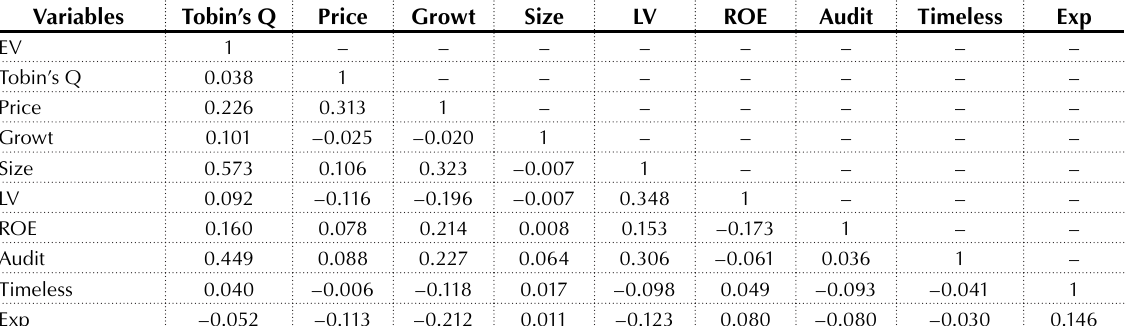
Table 3. Correlation matrix